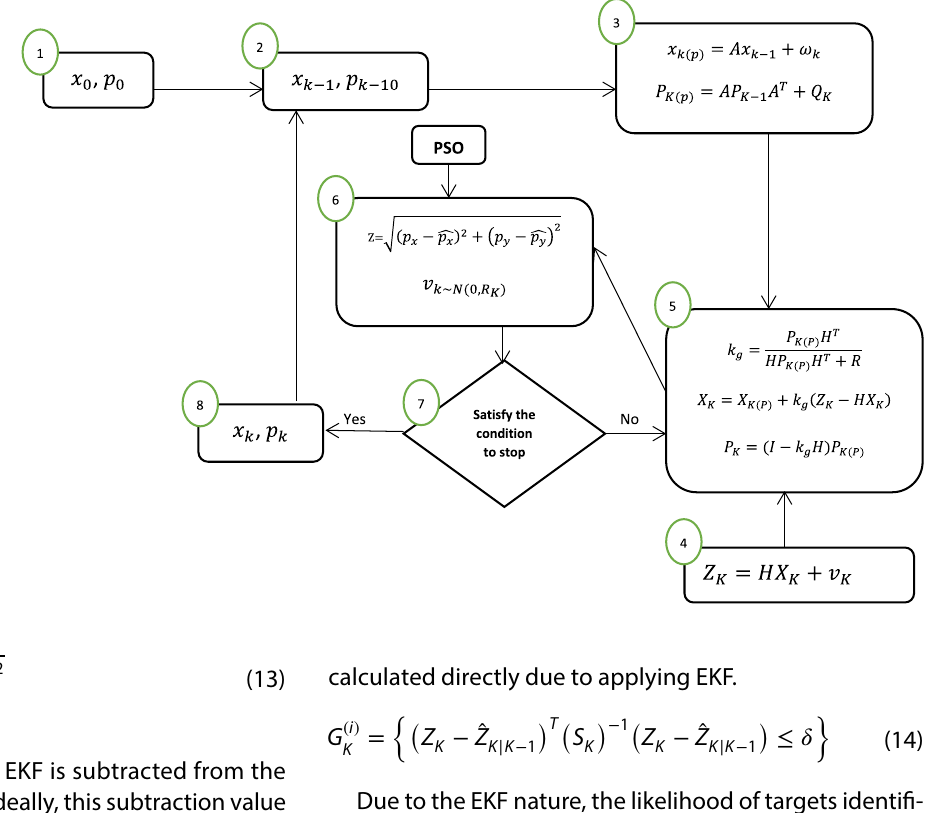
Fig. 4 Multiple targets inter- mediate tracker model in the proposed